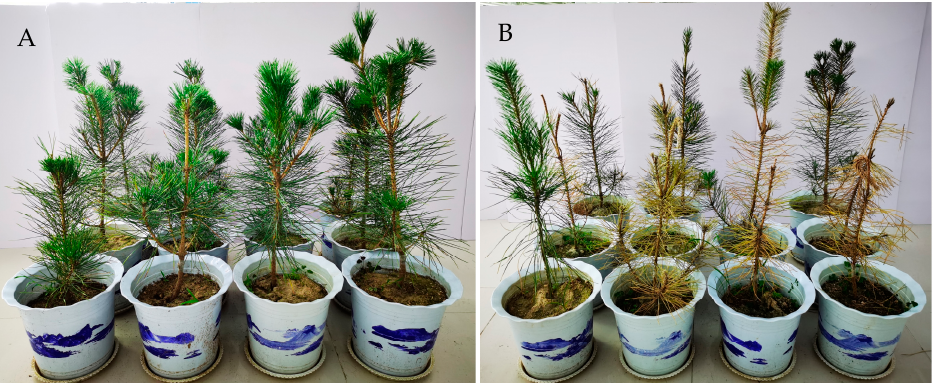
Figure 1. Effects of PWN infection on black pine seedlings. ( A ) The control group (CK). ( B ) The treatment group (BL).